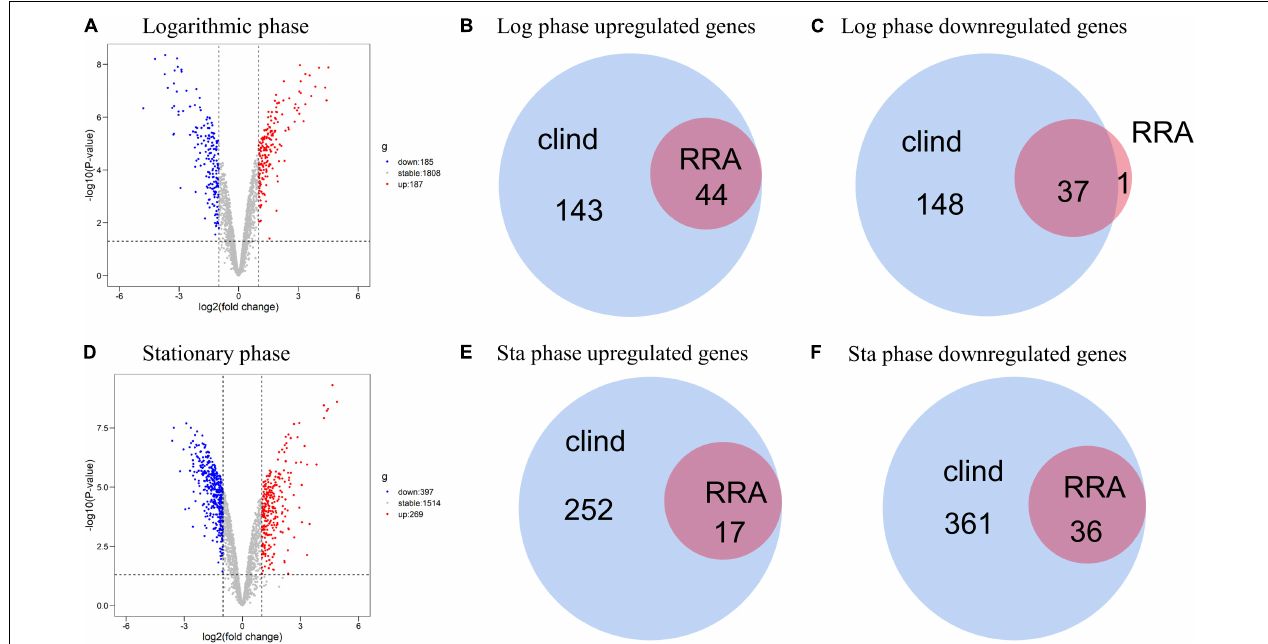
FIGURE 4 | Volcano plots of DEGs for clindamycin treated samples and Venn diagrams of DEGs identified in clindamycin treated samples and integrated data. (A) Volcano plots of DEGs identified in clindamycin treated samples during the logarithmic phase. (B,C) Venn diagrams of DEGs identified in clindamycin treated samples and integrated data during the logarithmic phase. (D) Volcano plots of DEGs identified in clindamycin treated samples during stationary phase. (E,F) Venn diagrams of DEGs identified in clindamycin treated samples and integrated data during stationary phase.